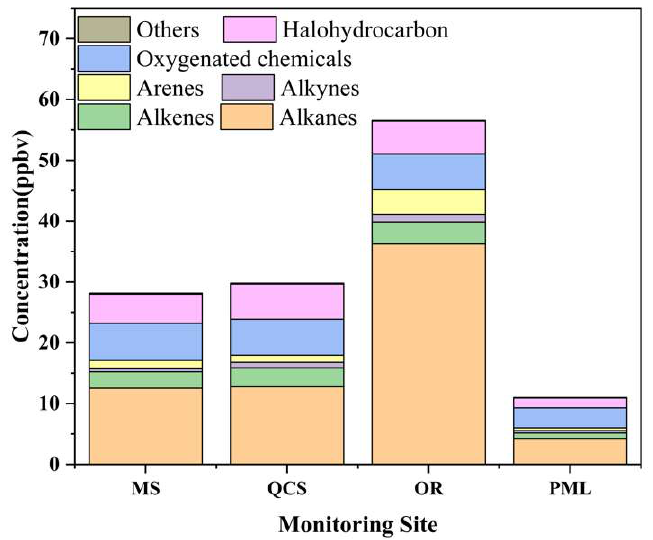
Figure 4. Volume fraction of volatile organic compounds at each site during the observations.